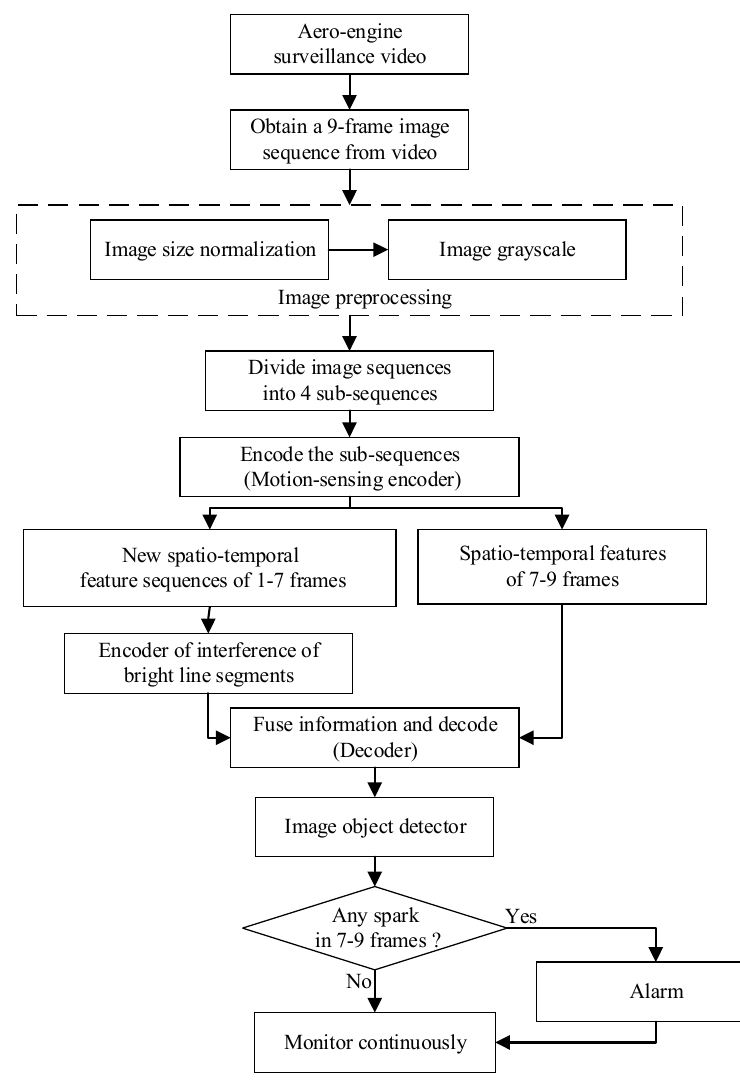
Figure 6. The proposed decoding model based on an information fusing mechanism. The flow chart of spark detection is shown in Figure 7.